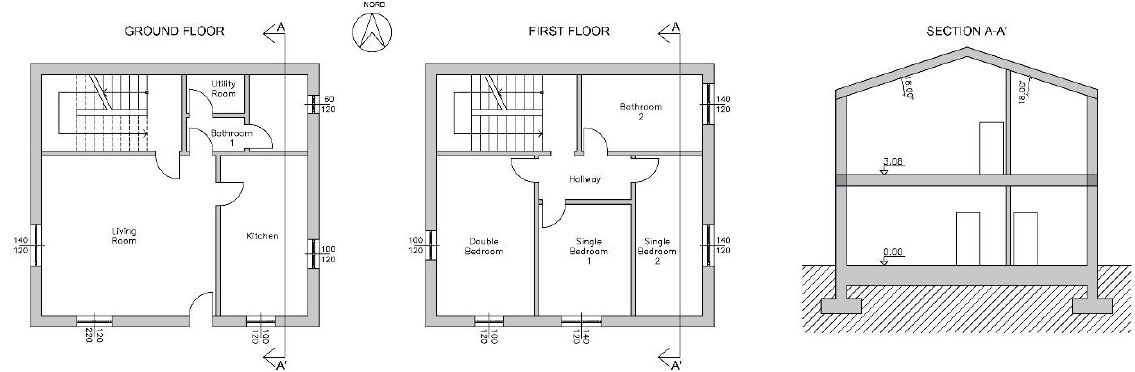
Figure 5. Plan view of the ground floor, first floor and section of the building model. Table 2. Geometrical characteristics of thermal zones.